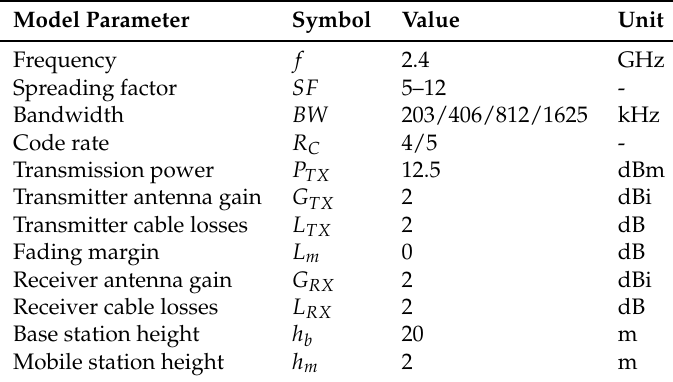
Table 1. Parameters used for path loss